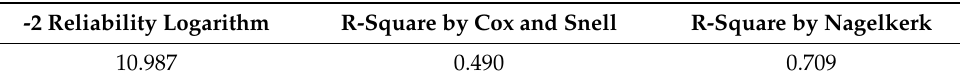
Table 8. Model—summary.